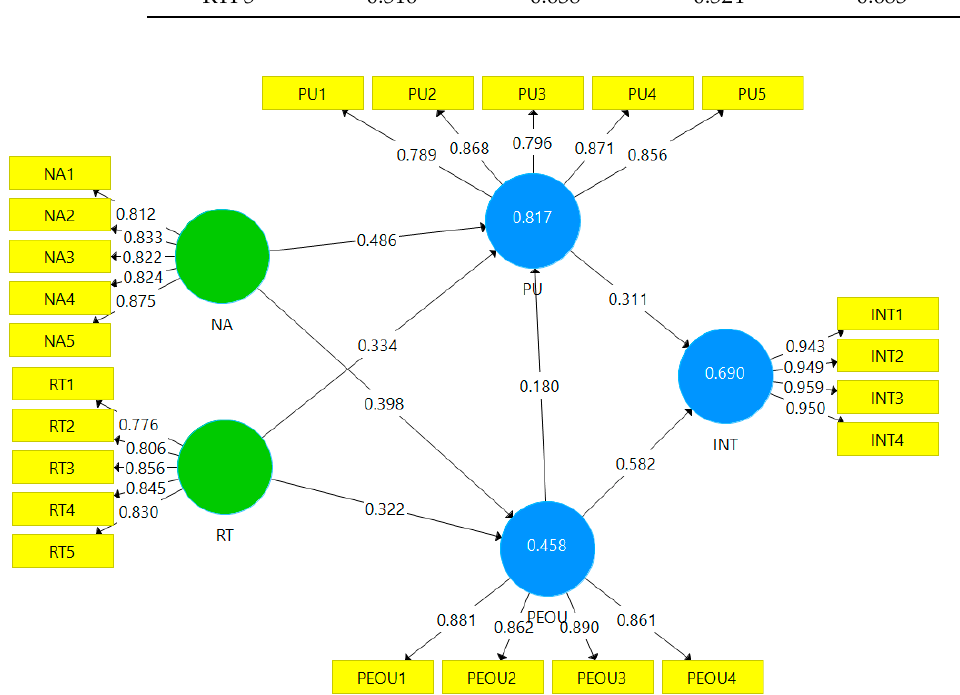
Figure 2. Structural model (standardized estimates).